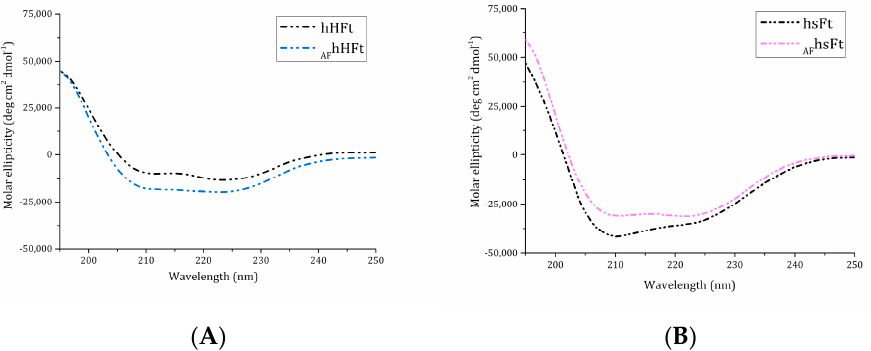
Figure 2. Far UV-CD spectra of AF hHFt (( A ), light blue dashes) and AF hsFt (( B ), pink dashes) in comparison to the spectra of the respective gold-free proteins (black dashes).